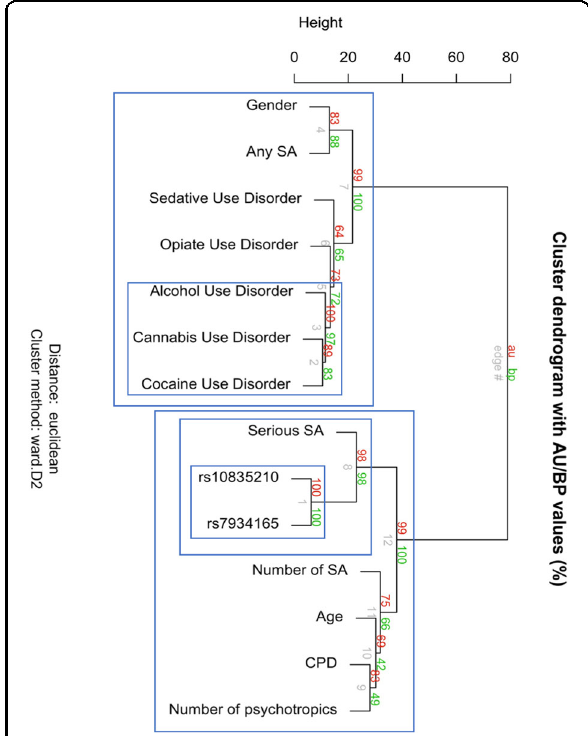
Fig. 3 Hierarchical clustering. Cluster dendogram using euclidian distance and D2, ward clustering of all variables associated with SA to some extent according to bivariate